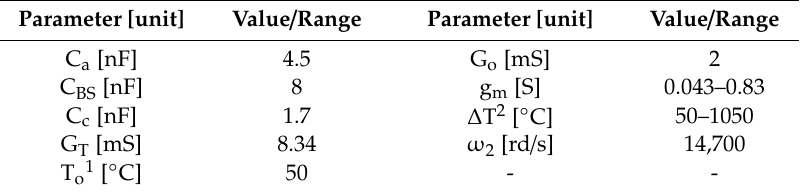
Table 1. Parameters of real temperature measurement line for first-order inertial transmitter. Parameter [unit] Value / Range